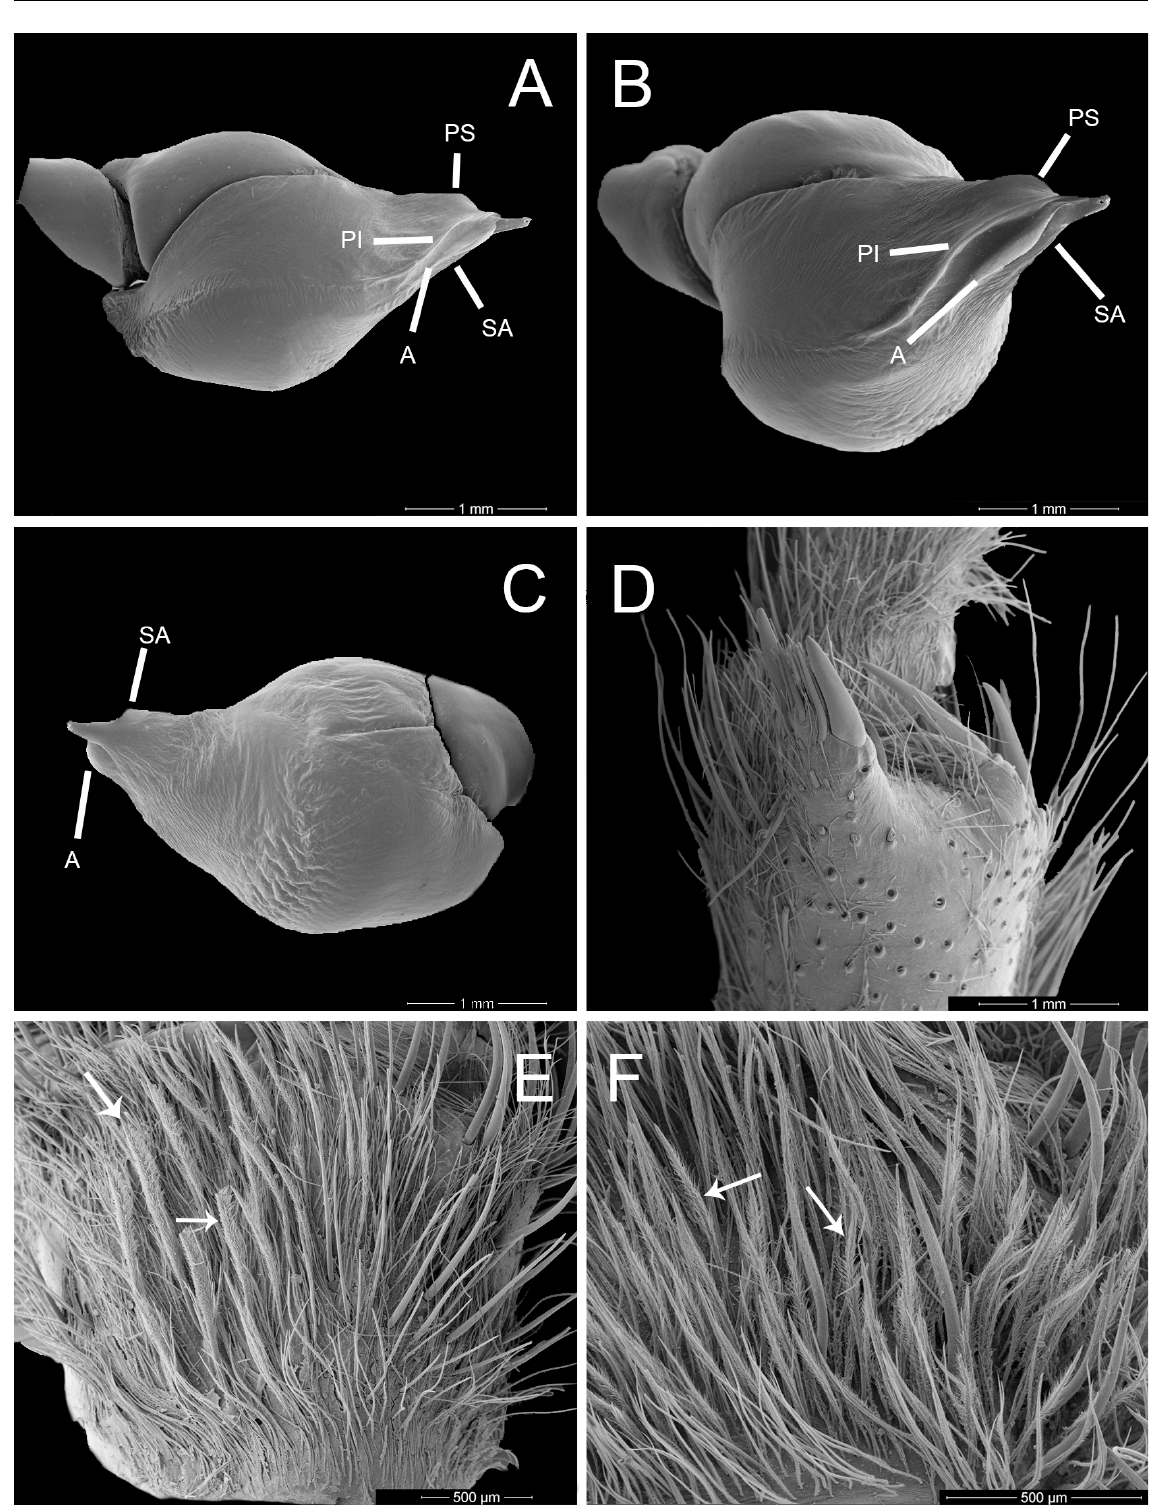
Fig. 8. Umbyquyra paranaiba gen. et sp. nov. Holotype, ♂ (IBSP 107411). A–C . Palpal bulb. A . Prolateral. B . Anterolateral. C . Retrolateral. D . Tibial apophysis, retrolateral. E . Stridulatory organ, trochanter, male palp. F . Stridulatory organ, trochanter I (arrows in E–F pointed the stridulatory bristles). Abbreviations: see Material and